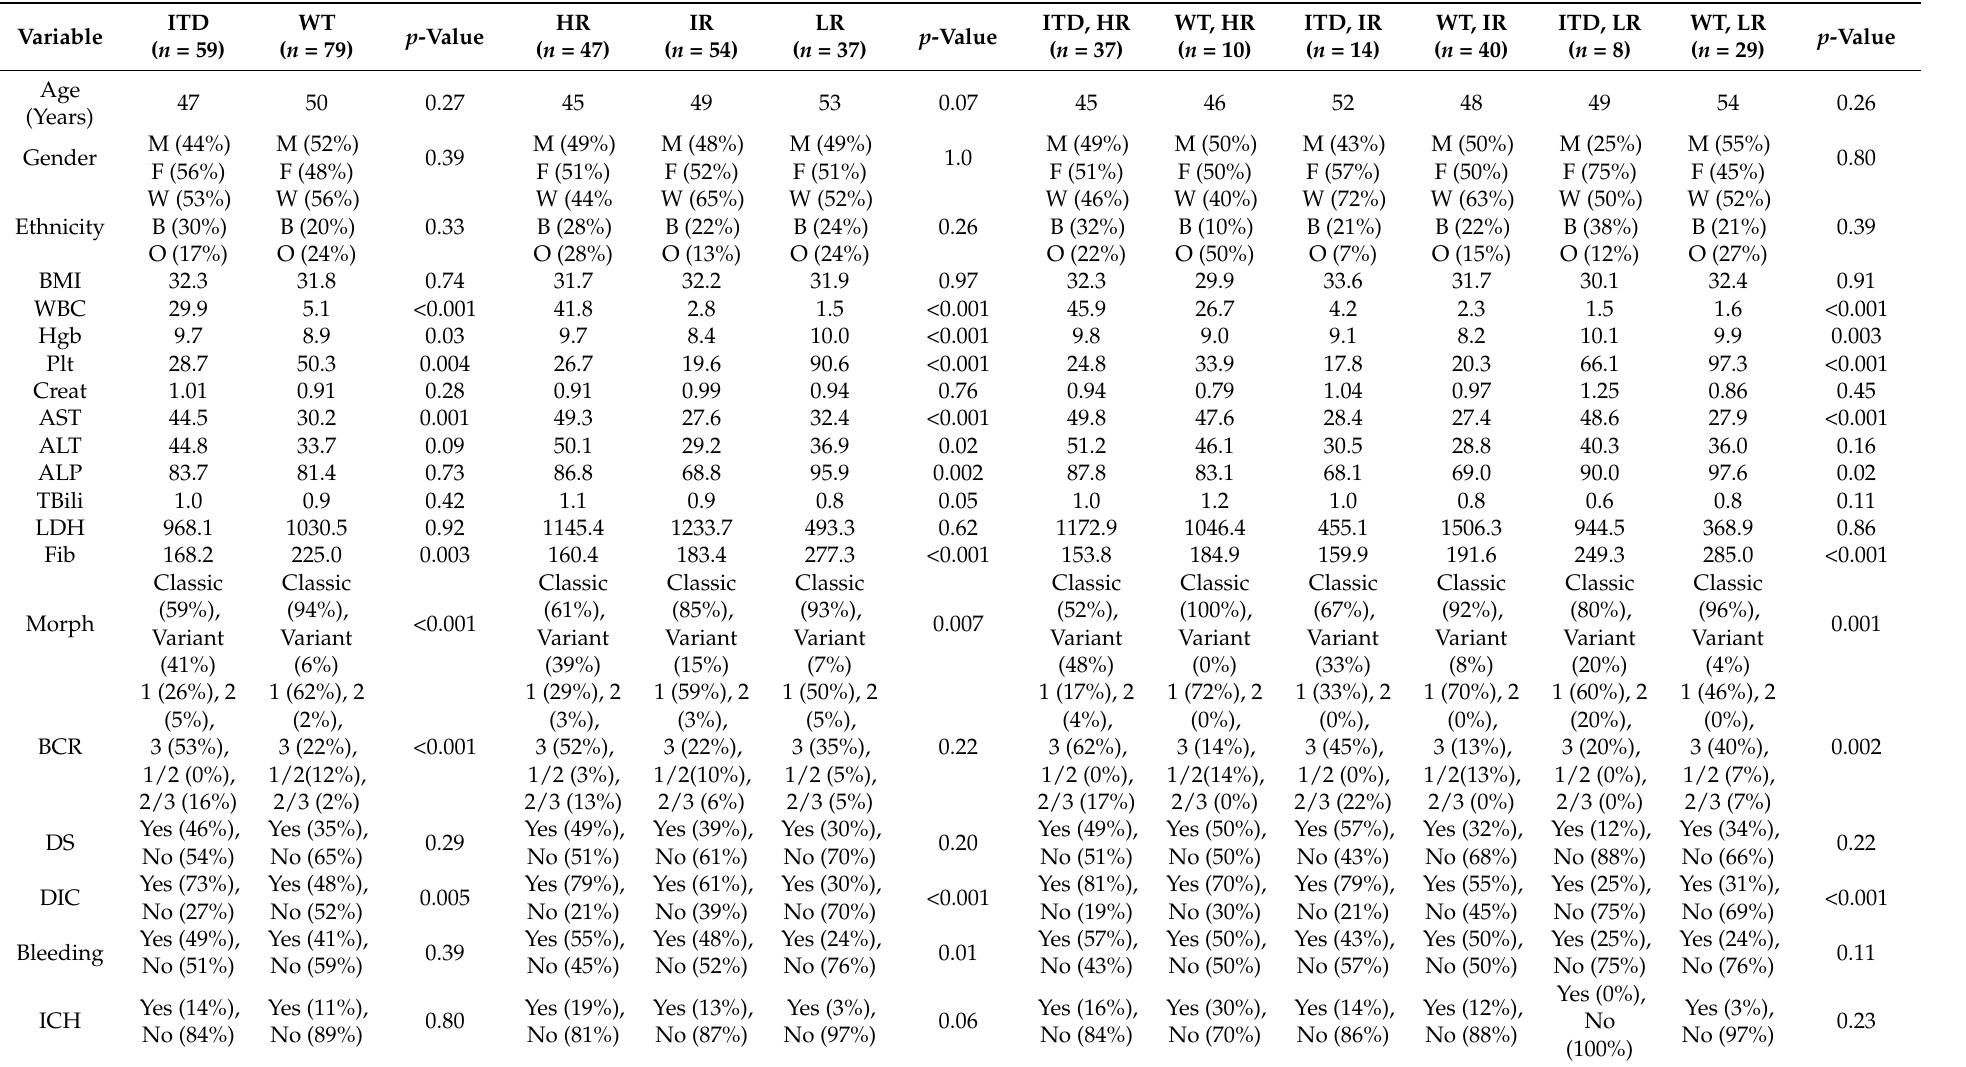
Table 1. Baseline demographic and clinical data of 138-patient acute promyelocytic leukemia (APL) cohort differentiated by presence of FLT3 -ITD and Sanz risk status. Variable